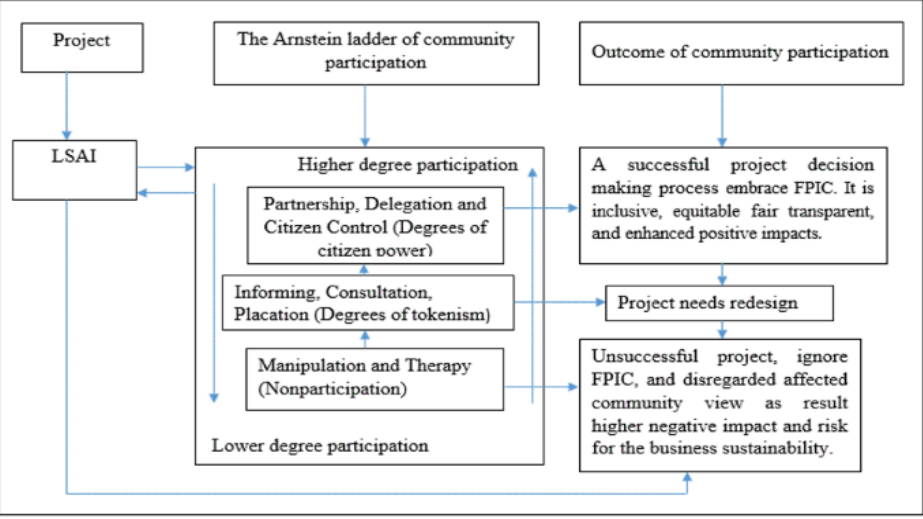
Figure 4. A conceptual framework for analyzing local people consultation and participation in LSAI. Source: authors’ compilation developed from Arnstein and Guaraldo [47,53].